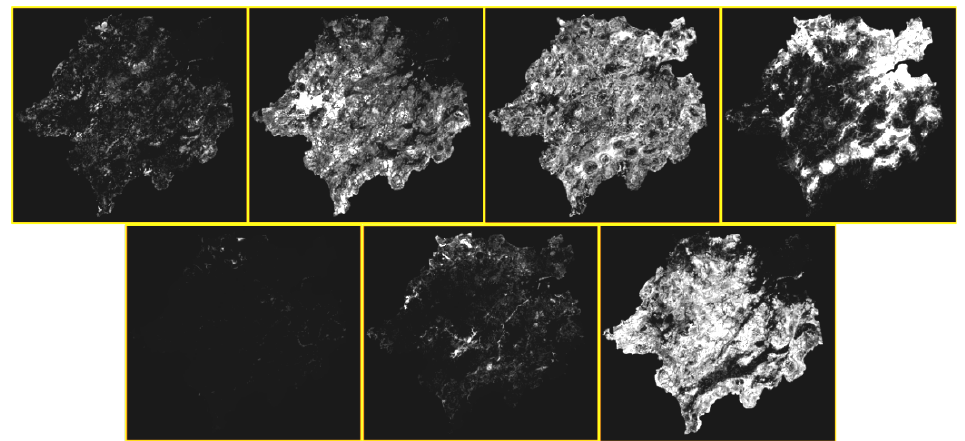
Figure 8. The development probabilities of various types of land, and the contribution of land expansion in 2010–2015 (the clearer the white, the greater the contribution).